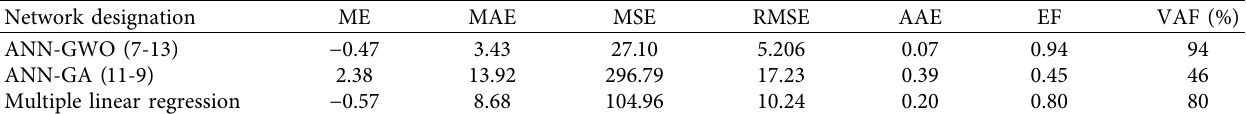
Table 8: Testing data statistics of the ANN-GWO, ANN-GA, and multiple linear regression models.